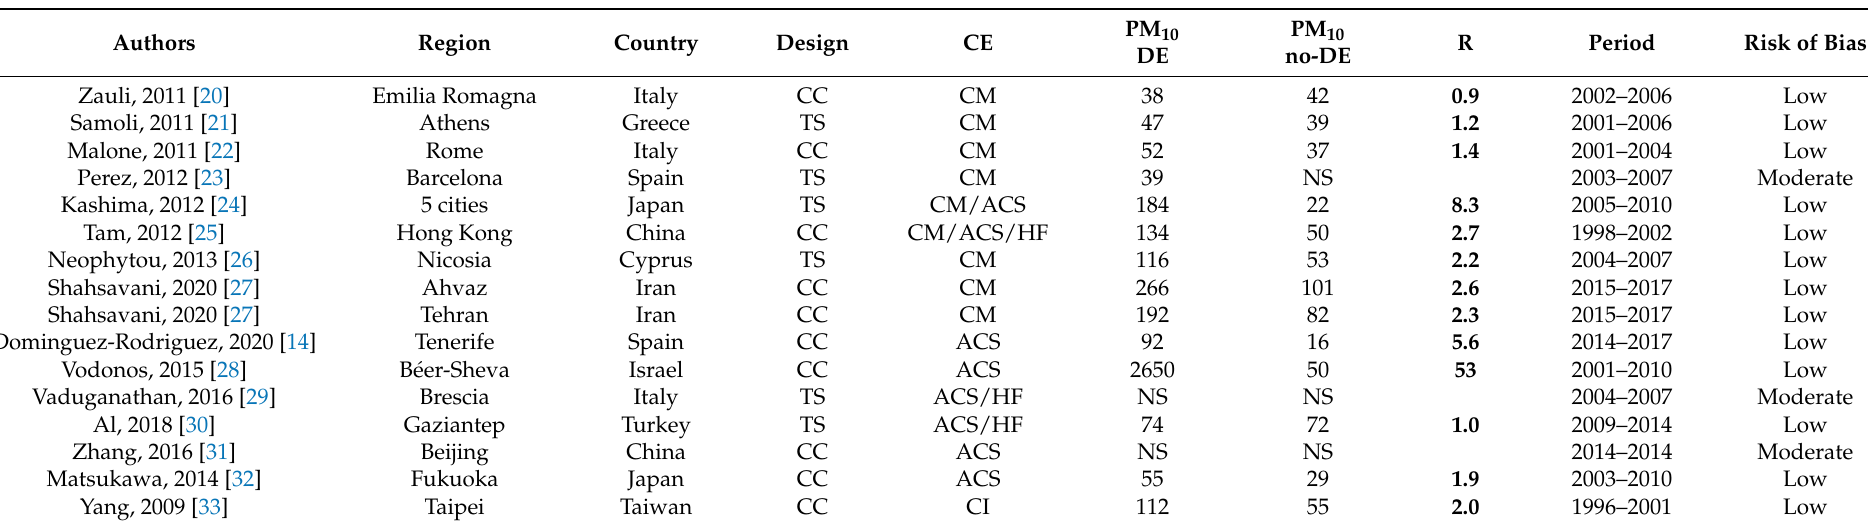
Table 1. Studies on the impact of desert dust on cardiovascular events identified in the systematic review for meta-analysis. The fraction of PM 10 linked to dust (DE) and no dust (no-DE) event is